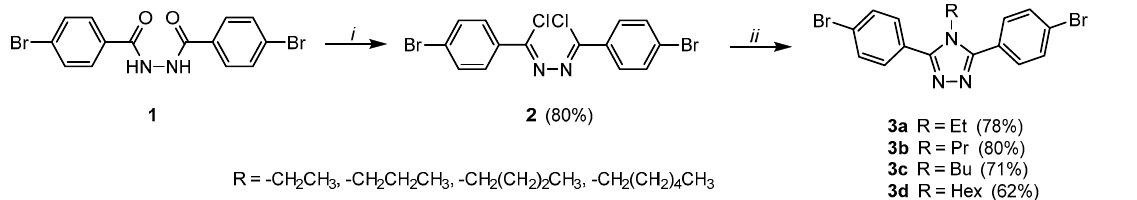
Scheme 1. Synthesis of 4-alkyl-4 H -1,2,4-triazole core. Reagents and conditions: ( i ) PCl 5 , toluene, reflux, 5 min; ( ii ) R-NH 2 , toluene, reflux, 10 h. Table 1. Products of the reaction of N , N (cid:48) -bis(4-bromobenzoyl)hydrazine ( 1 ) with PCl 5 and N , N (cid:48) -bis[(4-bromophenyl)chloromethylene]hydrazine ( 2 ) with butylamine. Product 2 Product 3c Entry 1: PCl 5 Ratio Temp. ( ◦ C) Time (min.) Yield (equiv.)